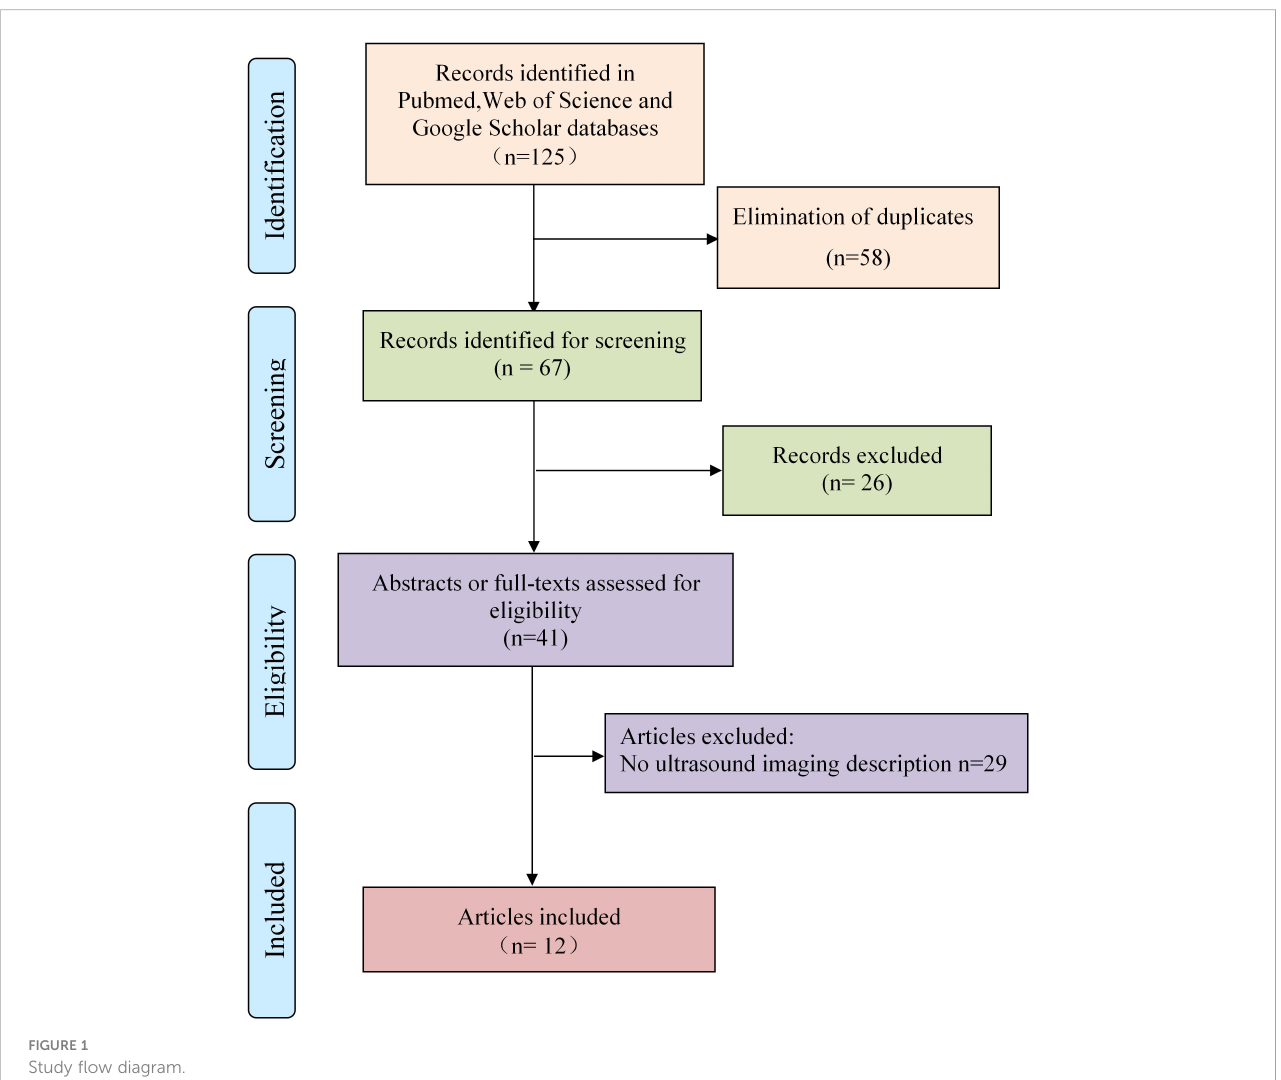
FIGURE 1 Study fl ow diagram.